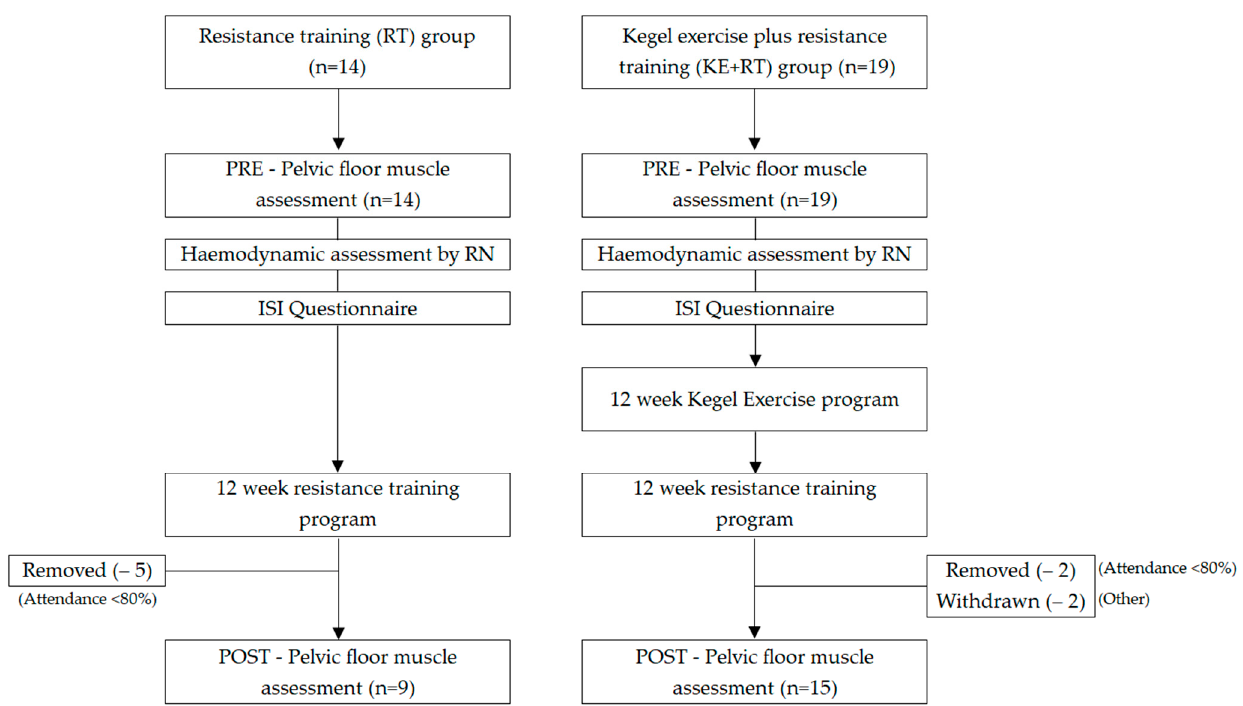
Figure 1. Summary of study protocol.